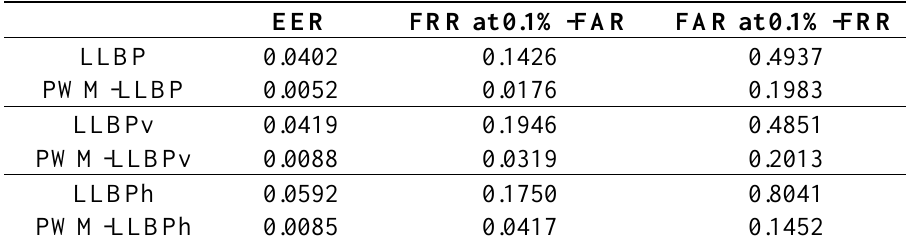
Table 6. Verification performance by different methods.